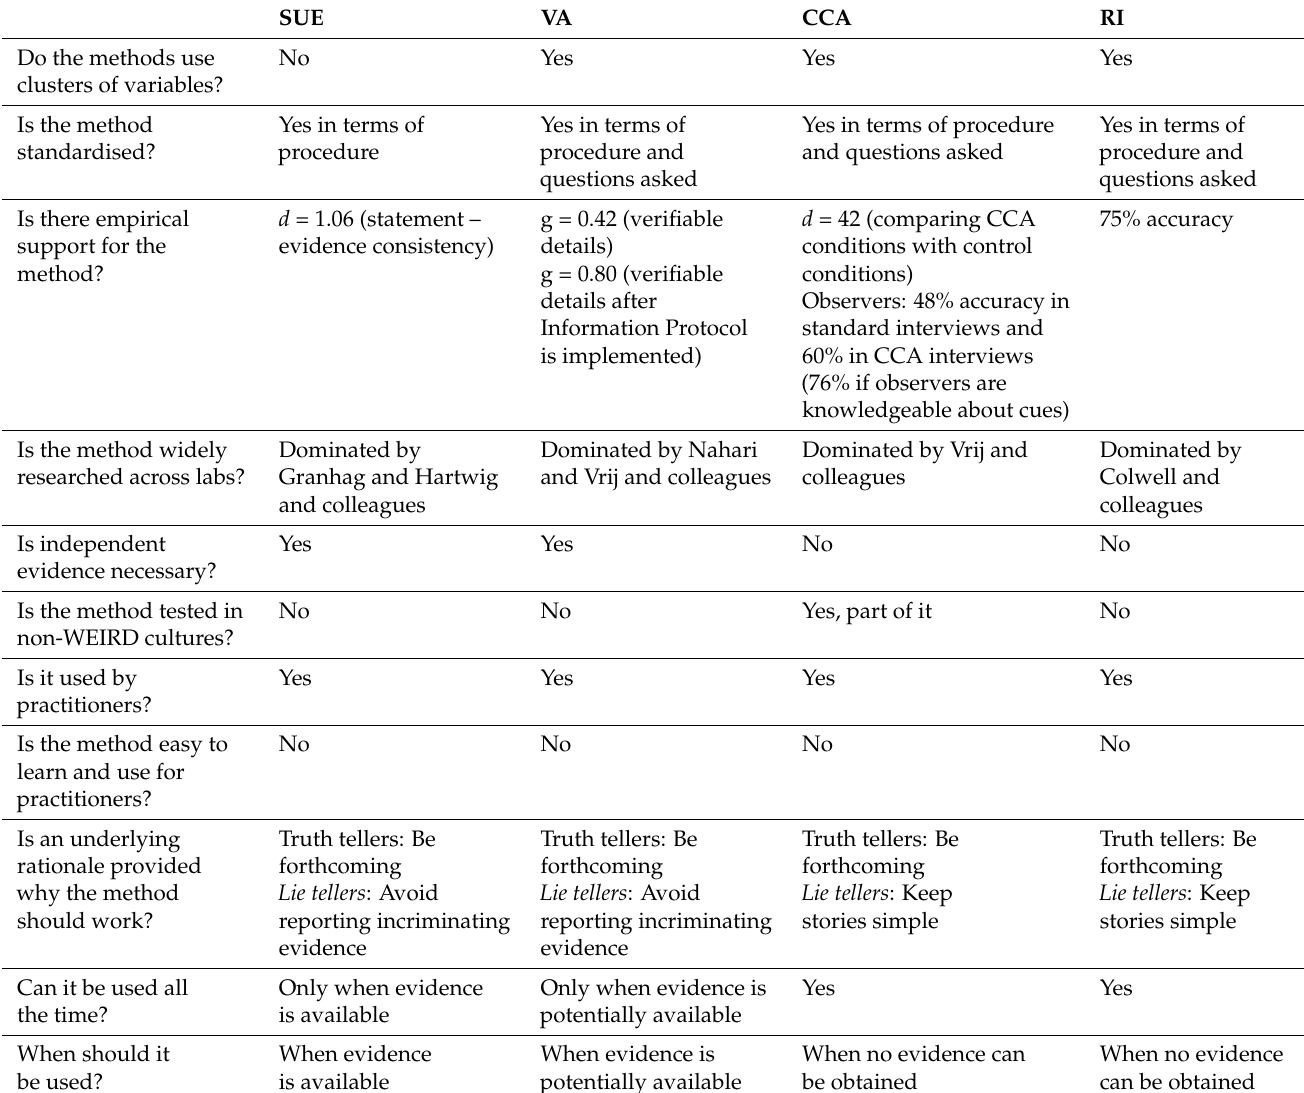
Table 2. A comparison between SUE, VA, CCA, and